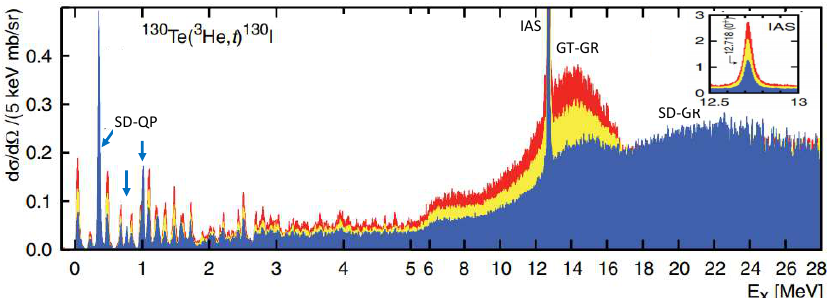
Figure 2. The energy spectrum of 130 Te( 3 He, t ) 130 I [15]. IAS, GT-GR, and SD-GR are Fermi 0 + , GT 1 + , and SD 2 − giant resonances, respectively. The energy scale below 5 MeV is enlarged by a factor 2 to make the sharp peaks visible. F and GT transitions with L = 0 are enhanced at the forward angles of 0–0.5 deg. (red) and 0.5–1 deg. (yellow), while the SD ones with ( L = 1) at a larger angle of 1–1.5 deg. (blue). Thick blue arrows: SD QP